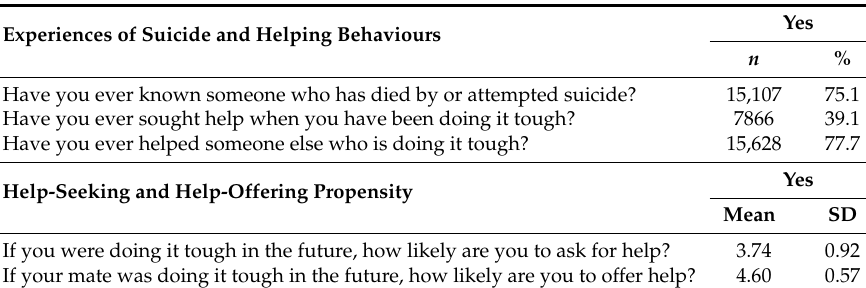
Table 2. Attitudes and